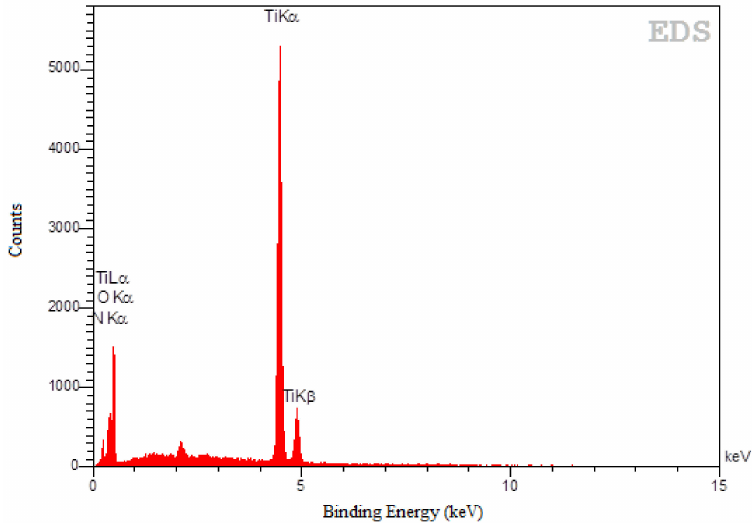
Figure 4. Energy dispersive X-ray spectroscopy (EDS) pattern of the as-prepared N-doped TiO 2 catalyst. Furthermore, the FE-SEM images of the surface of roughened uncoated glass beads in different magnitudes and the surface of the coated ones in the same magnitude beside each other are shown in Figure 5. As seen in the images of Figure 5a on the left side, the uncoated glass beads have a roughened surface with wrinkles and cracks. The images of coated glass beads in Figure 5b on the right side, obviously confirm the deposition of N-doped TiO 2 nanoparticles on their surface which in a proper zoom the spherical morphology of the prepared catalysts in agglomerated form could be seen on the surface of these coated glass beads, the same as the SEM images of prepared catalysts in Figure